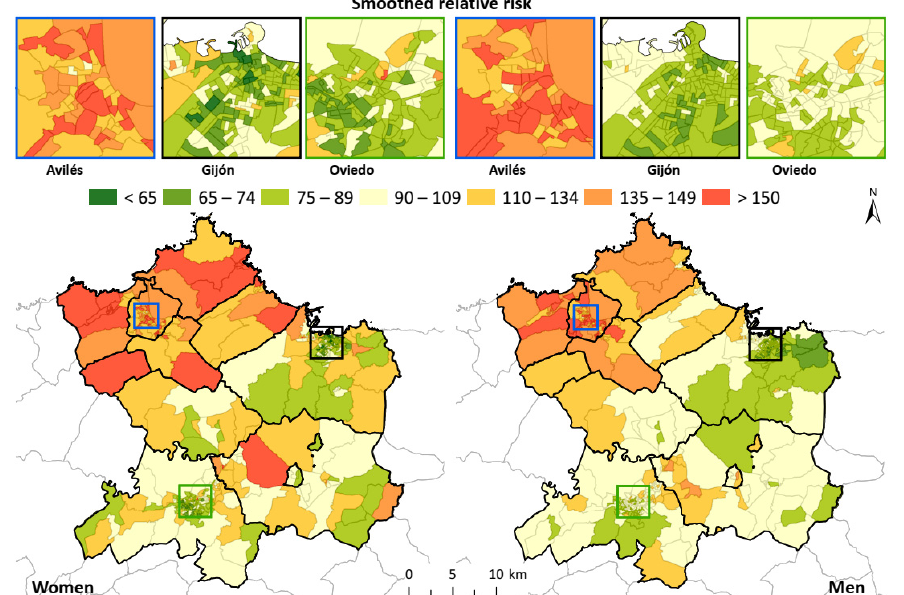
Figure 3. Smoothed relative risk for AMI and AP in the study area. For both men and women, the concentration of values was above 100 in the northwest of the study area, which corresponded to the area of Avilés and neighboring municipalities, reaching the west of Gijón. Oviedo and Gijón center areas show lower values across the cities compared with Avilés.